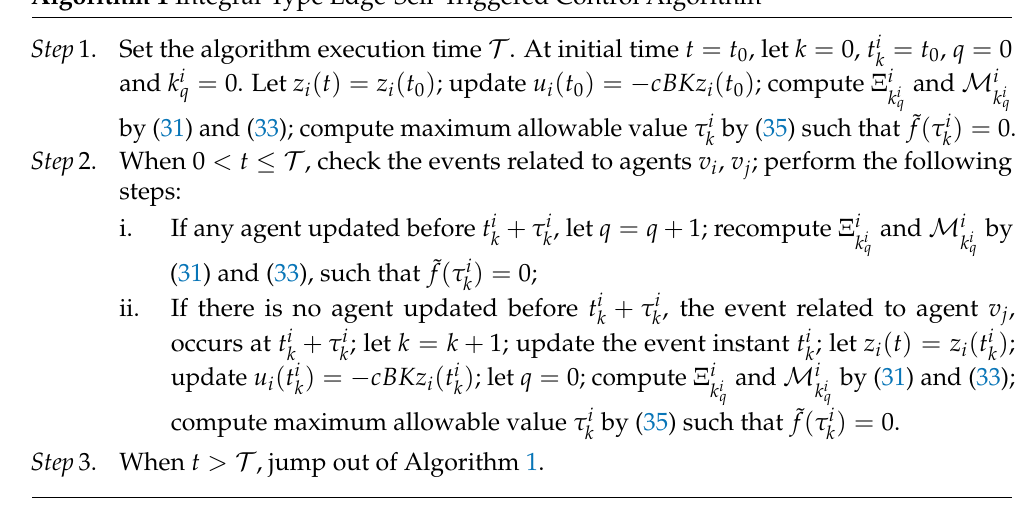
Algorithm 1 Integral-Type Edge-Self-Triggered Control